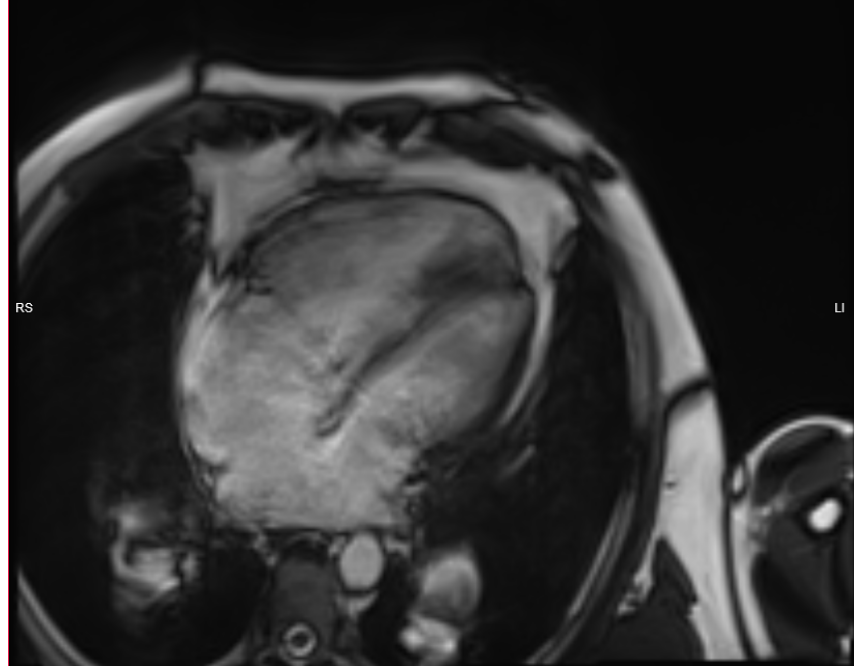
Figure 3. Magnetic resonance imaging shows the overload of the right heart and large secondary ASD (4.2 × 5.4 cm).